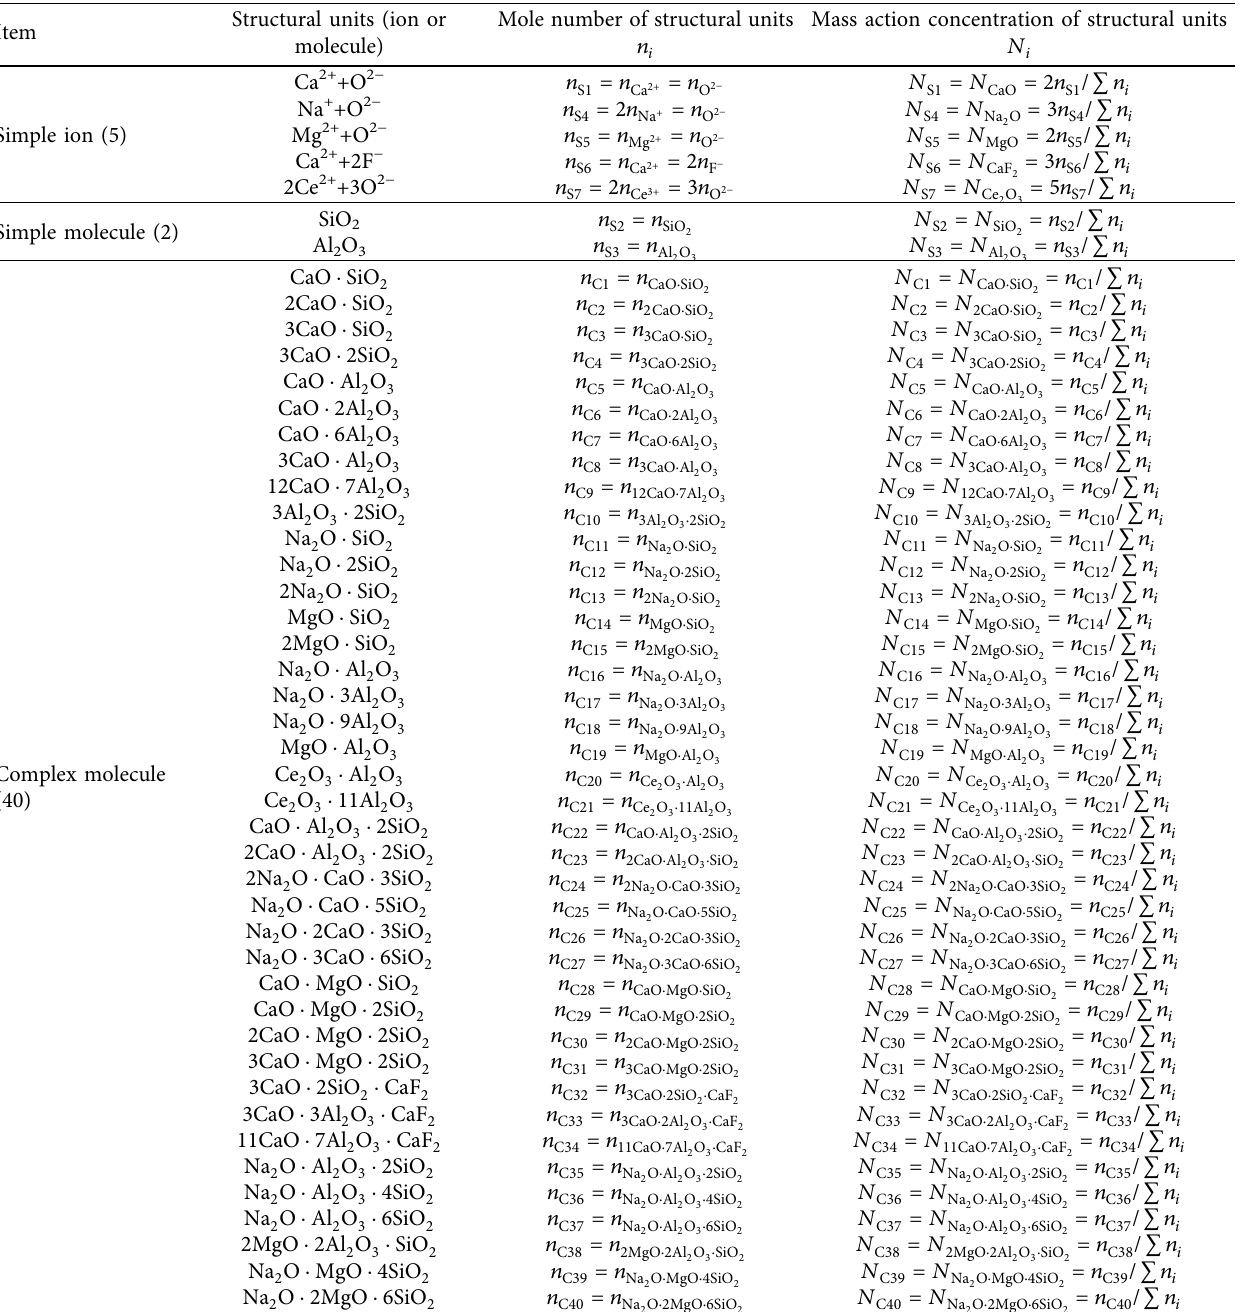
Table 4: Expression of structural units, their mole numbers, and mass action concentrations in 100g CaO-SiO Ce 2 O 3 slags based on IMCT.